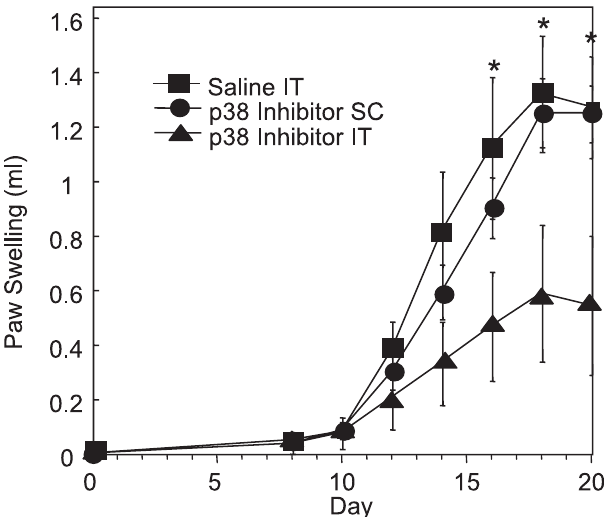
Figure 2. Effect of IT p38 Inhibitor on Paw Swelling in Adjuvant Arthritis Rats were immunized with CFA on day 0 and treated daily with IT p38 inhibitors (SB203580 at 8 l g/d), SC p38 inhibitor (SB203580 at 8 l g/d), or IT saline beginning on days 8–20. Paw swelling was measured by water displacement plethysmometry. The IT p38 inhibitor significantly decreased paw swelling (* p ¼ 0.001 by ANOVA and Dunnett’s post- ANOVA test; n ¼ 5–6/group). This graph presents data from one of three separate experiments with similar results. DOI: 10.1371/journal.pmed.0030338.g002